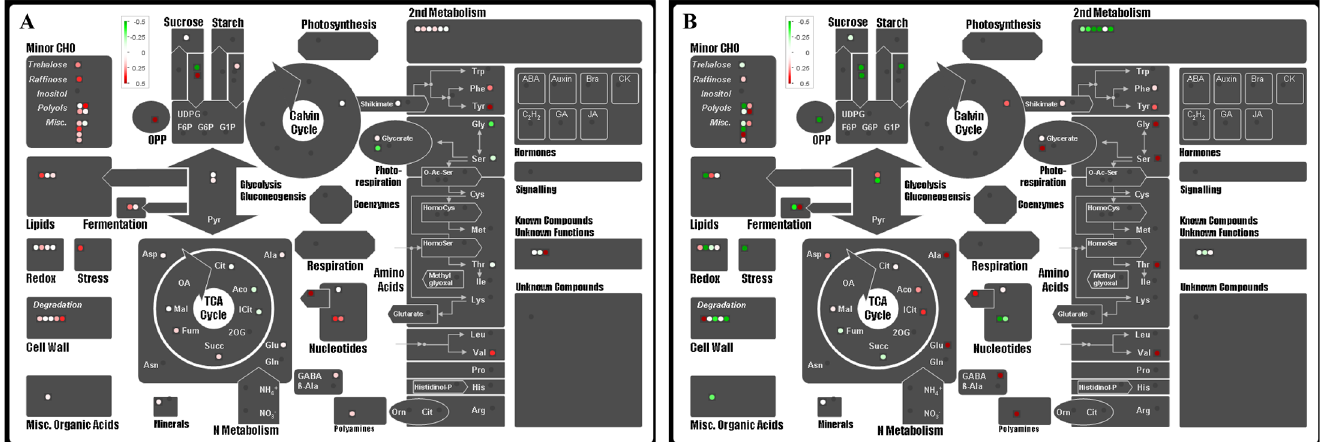
Fig 3. Display of changes of metabolites in NIL- SS1 compared to that in Teqing. The samples were harvested at the tillering (A) and booting stage (B), respectively. A coloration represents 50% changes